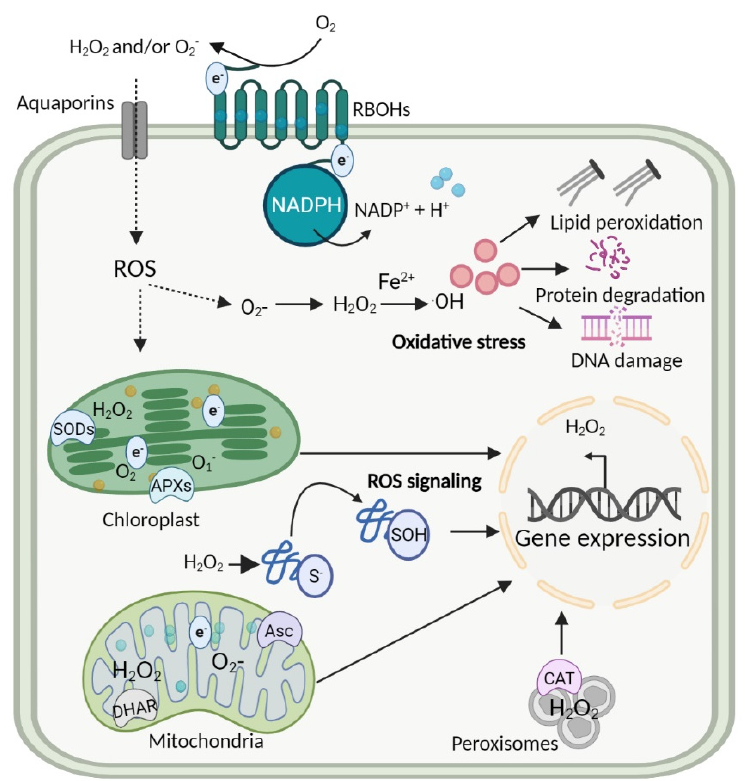
Figure 1. The oxidative stress signaling in plant cell compartments. ROS, such as O 2 •− and H 2 O 2 are produced by NADPH oxidases specifically RBOHs at the apoplast, accumulating in chloroplast, mitochondria, peroxisomes, and nuclei. Accumulation of H 2 O 2 in the presence of F 2+ form hydroxyl radicals and initiates oxidative stress that results in distorting the structure of lipids, proteins, and DNA. Later, the integration of enzymes, such as SODs, APXs, DHAR, and CAT in cell organelles maintains ROS levels and gene expression.